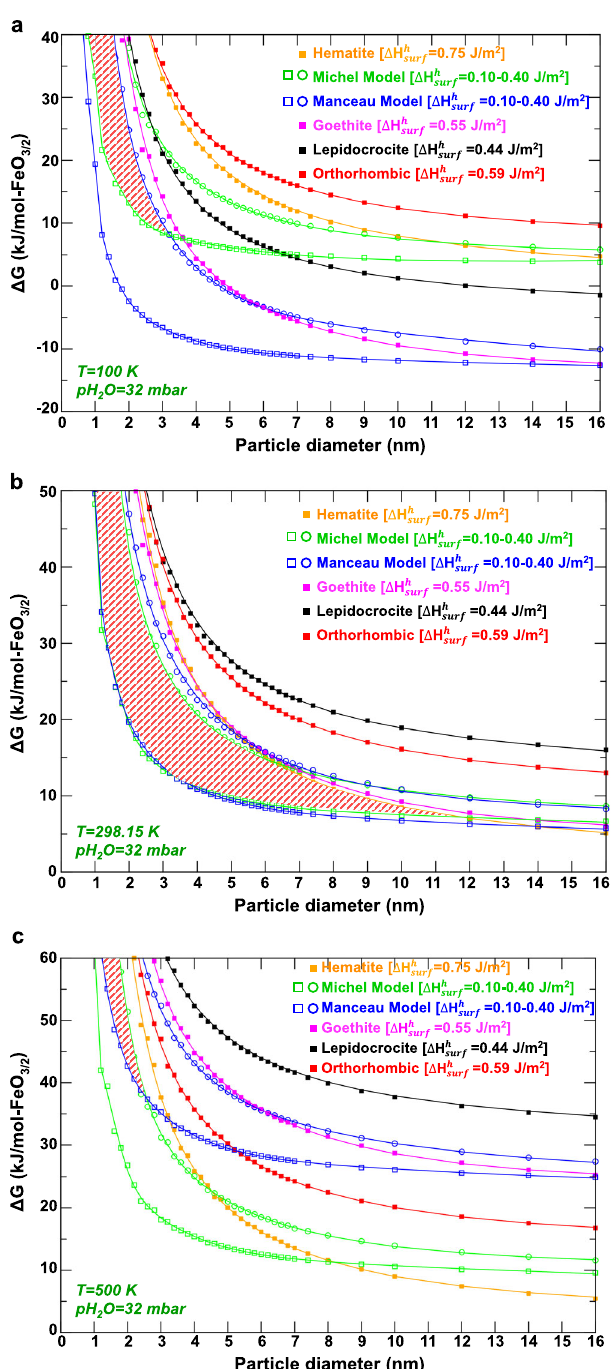
Fig. 5 Coexistence of structurally different Fh nanoparticles. Particle-size dependency of the relative phase stability of the Manceau and Michel ferrihydrite models as well as for goethite, lepidocrocite, hematite, and the orthorhombic phase for p H 2 O = 32mbar and ( a ) T = 100K, ( b ) T = 298.15K, and ( c ) T = 500K. For the two ferrihydrite models, the curves with open squares were obtained using Δ H h surf = 0.10J/m 2 , while the curves with open circles used Δ H h surf = 0.40J/m 2 . Square fi lled curves used Δ H h surf calculated for hydroxylated periodic surface crystals. The red hatched area represents the size range of particles for which the two ferrihydrite models can potentially